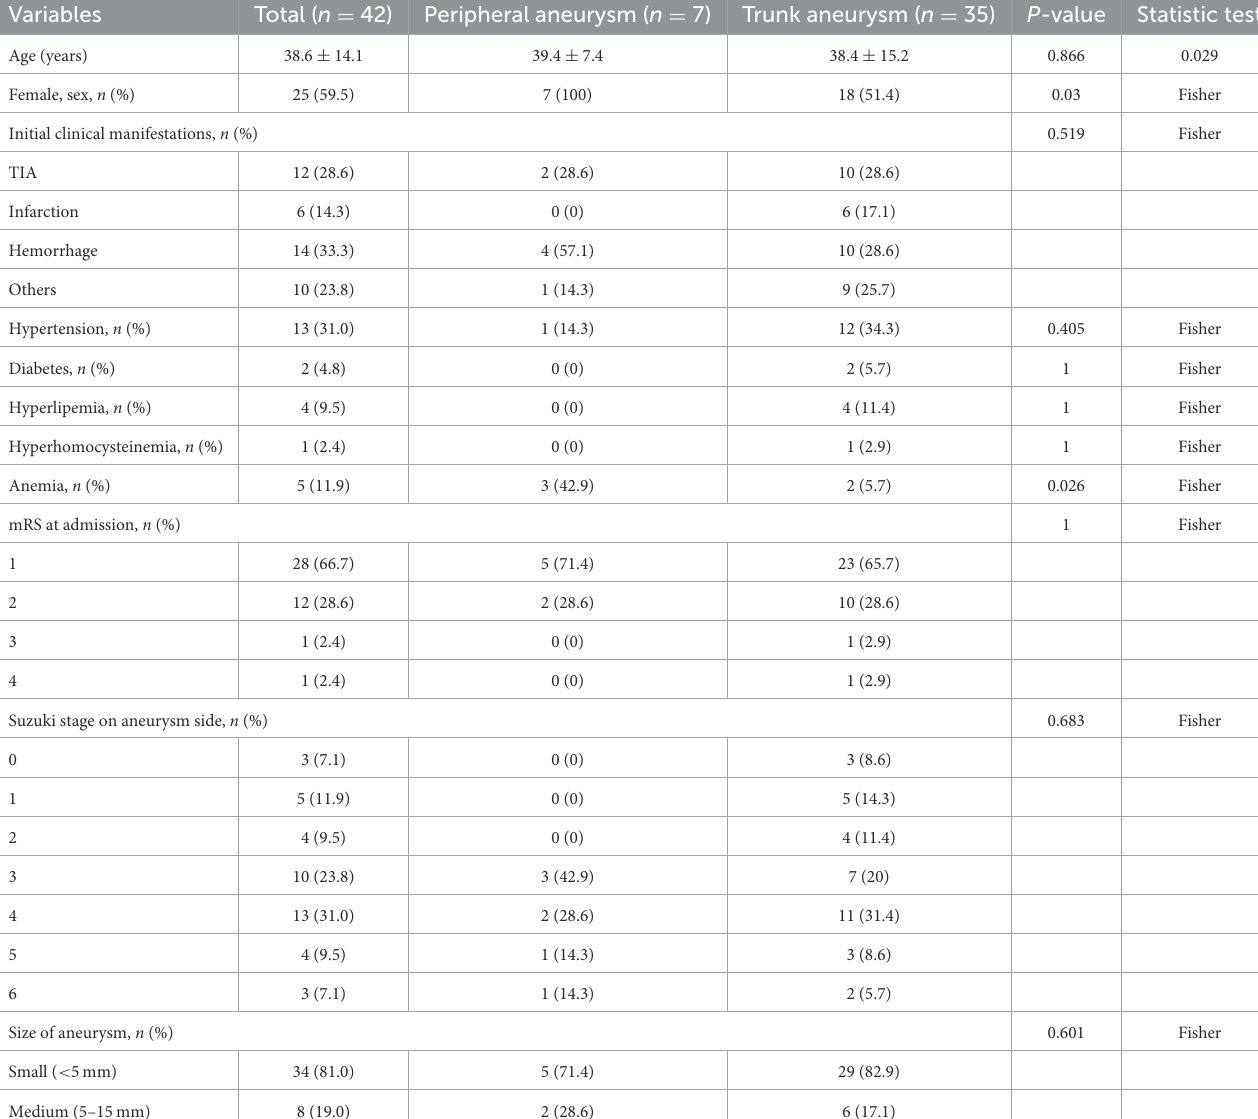
TABLE 1 Clinical features of 42 patients with MMD with intracranial aneurysms.